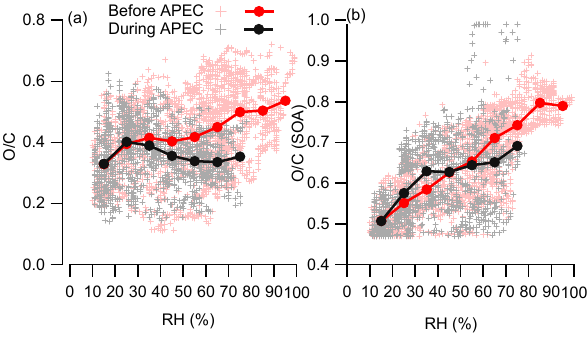
Figure 11. Variations in (a) O / C and (b) O / C of secondary or- ganic aerosol (SOA) as a function of relative humidity (RH) mea- sured (a) before the Asia-Pacific Economic Cooperation (APEC) summit and (b) during APEC. The data are also binned according to RH with increments of 10%.